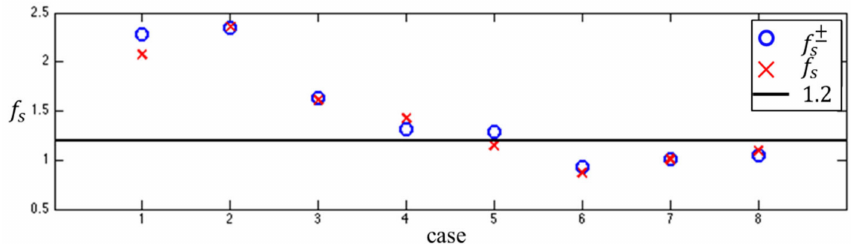
Figure 10. Comparisons of the safety factors against sliding among the minimum of f s ± (o), f s ( × ) and safety criteria 1.2(—).